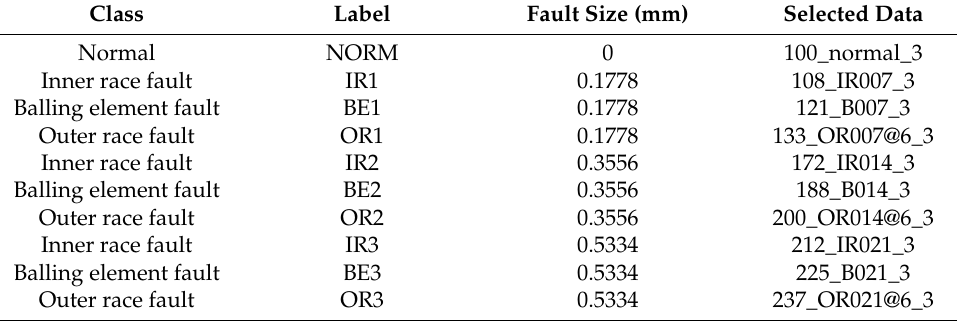
Table 1. Details of the selected bearing signals.